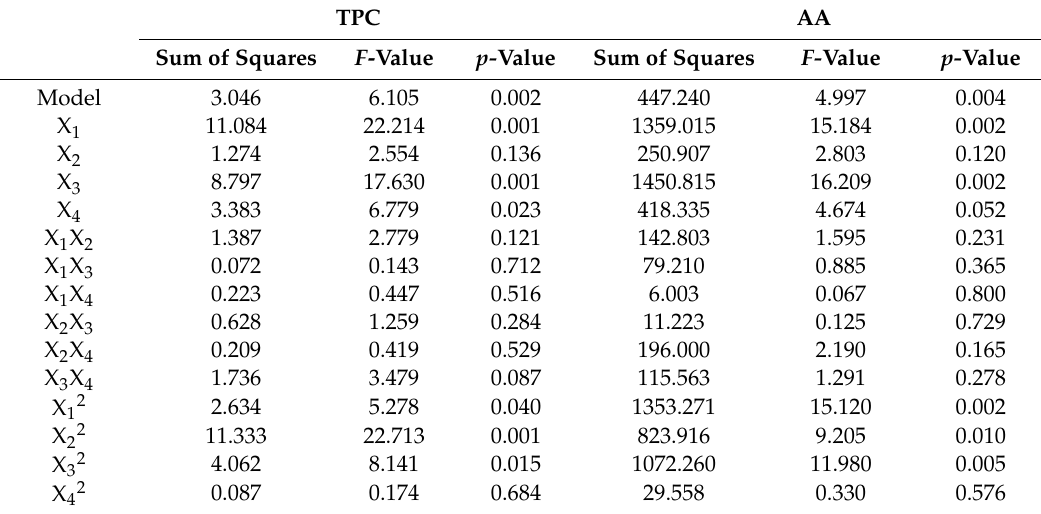
X 32 4.062 8.141 0.015 1072.260 11.980 0.005 X 42 0.087 0.174 0.684